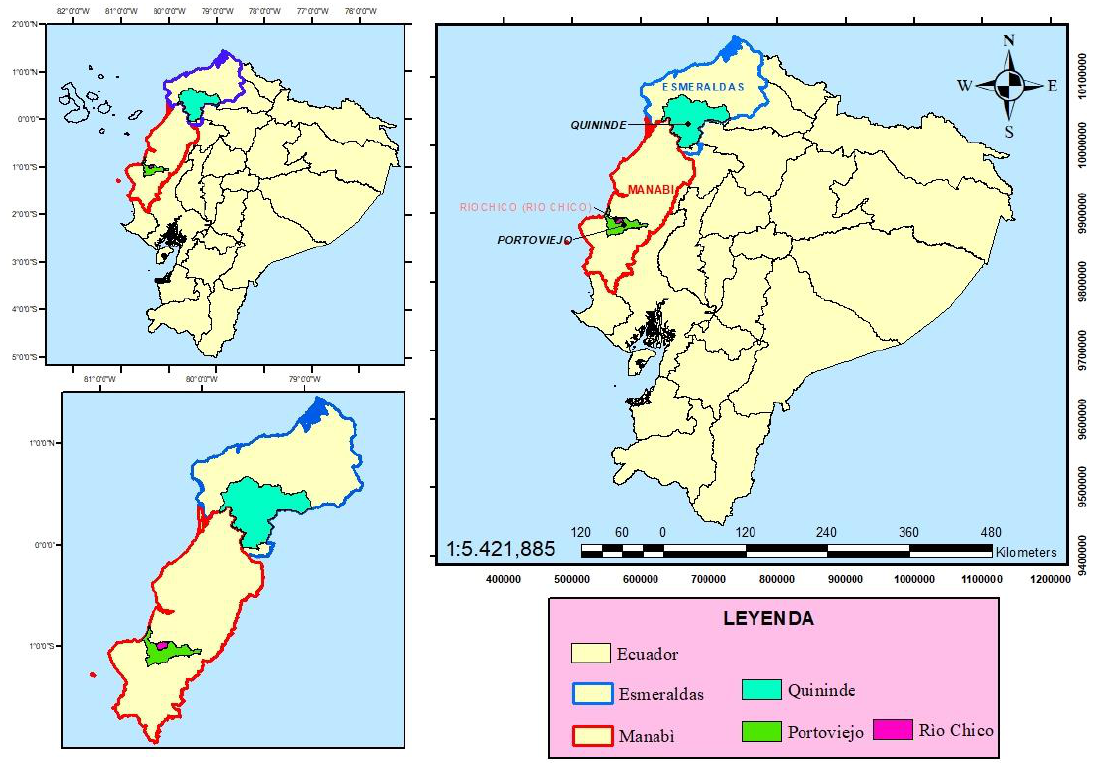
Figure 1. Geographic location of the sampling zones. Produced by: Ing. Juan García Cabrera. Mg. Sc and Ing. Alfredo Valverde Lucio. Mg. Sc.